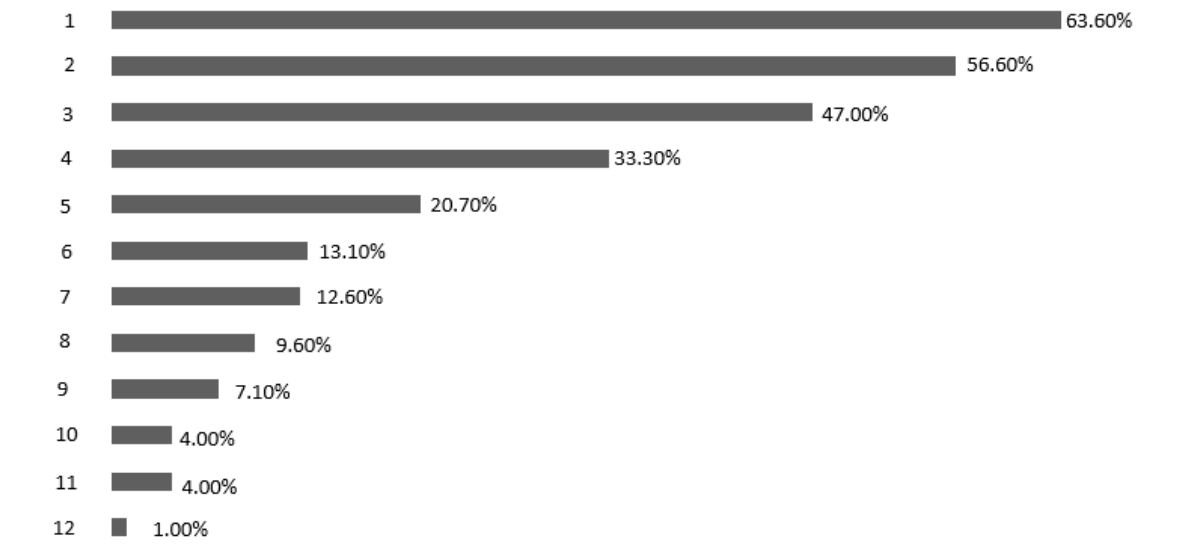
Figure 1. Reported contraindications to the sentinel lymphadenectomy in vulvar cancer. 1 = tumor > 4 cm; 2 = previous radiotherapy in the area of the lymphatic drainage; 3 = multifocal tumor; 4 = previous surgery of the groins; 5 = previous excisions of the vulva; 6 = no contraindications; 7 = tumor of the midline; 8 = tumor > 2 cm; 9 = suspicious lymph nodes (clinical examination and/or after imaging procedures); 10 = preexisting chronic conditions of the vulva; 11 = previous chemotherapy; 12 = individual factors.